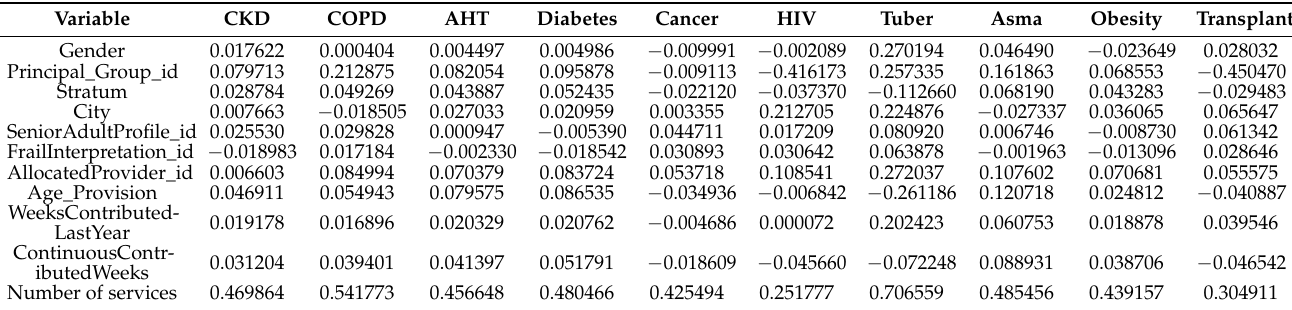
Table 4. Correlation with the InvoicedValue field.